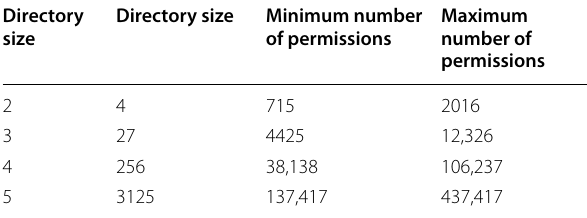
Table 2 Specifics of directory